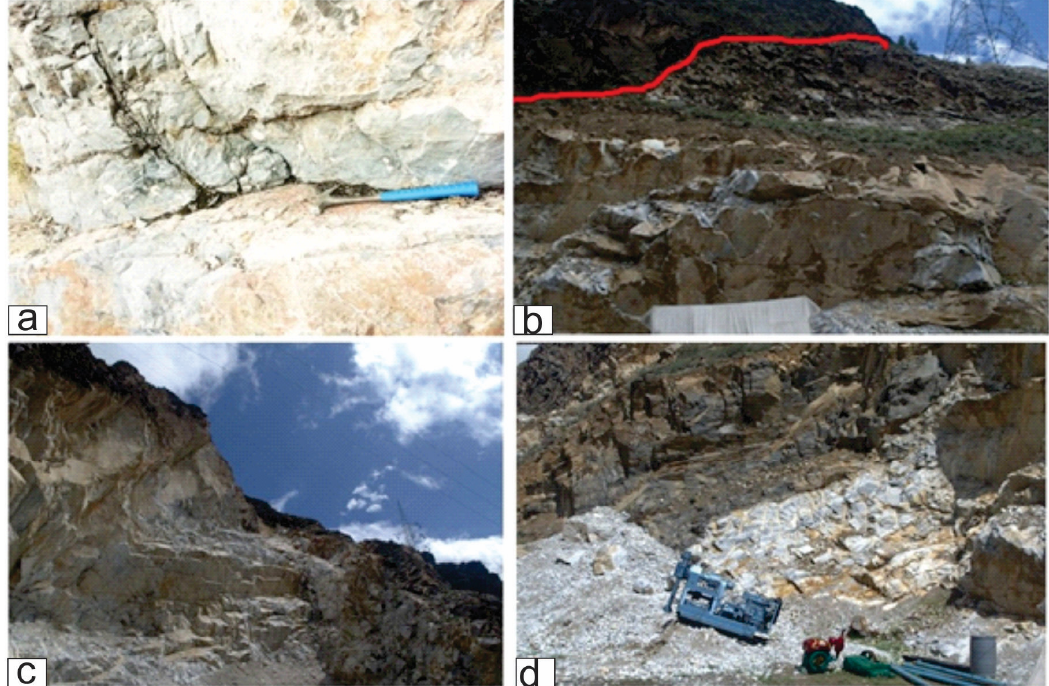
Figure 2. Exposed Unit of Gahirat Marble ( a ) showing gray color Gahirat Marble near the Chinar area. ( b ) The line showing contact between Chitral slates and Gahirat Marble near Gahirat Gol area. ( c ) Type locality of Gahirat Marble showing white color near Gahirat village. ( d ) Showing intrusive contact of Kesu-Buni zone granodiorite with Gahirat